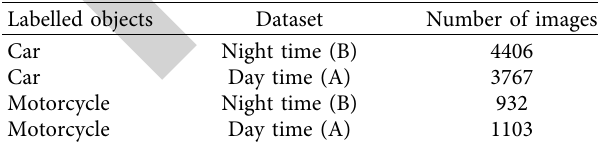
Table 3: Split of data into training, validation, and test based on